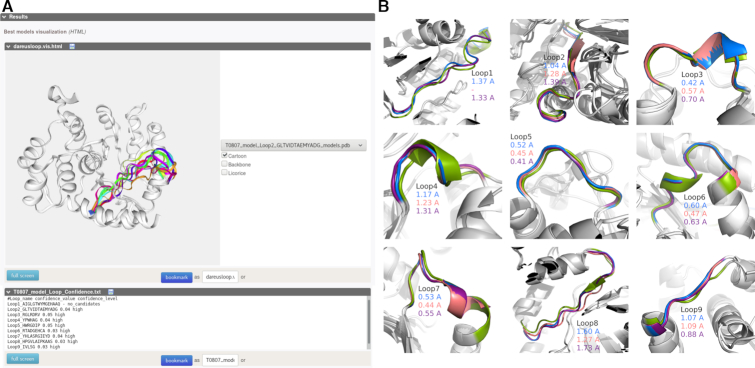
Illustrative example of DaReUS-Loop performance. Nine loops from the homology model of T0807 in CASP11 test set are modelled separately, in each of the three modes (remodeling, modeling and advanced modeling). (A) Example of result page provided by the web server for modeling loop number 2 (residues 45–58), using the modeling scenario. Top: final top 10 candidates predicted by the server are visualised on the structure using different colors. Bottom: the confidence values and levels for every loop are reported. (B) For every loop, the best predictions of each model are shown (remodeling: blue, modeling: pink and advanced modeling: purple) and the native loop conformations are depicted in green. The loops are spanning the following residues, respectively: 16–30, 45–58, 69–75, 82–87, 113–119, 154–162, 168–178, 234–245 and 258–262. The RMSD of the top candidate is reported with respect to the native loop conformation, after fitting on the flanks.